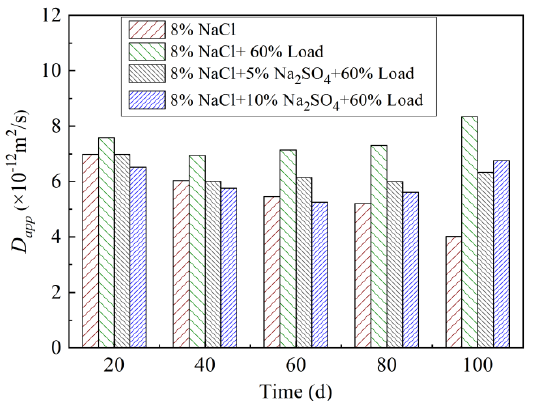
Figure 6. D app of concrete immersed in different sodium sulfate and sodium chloride coupling of the cyclic loading condition.